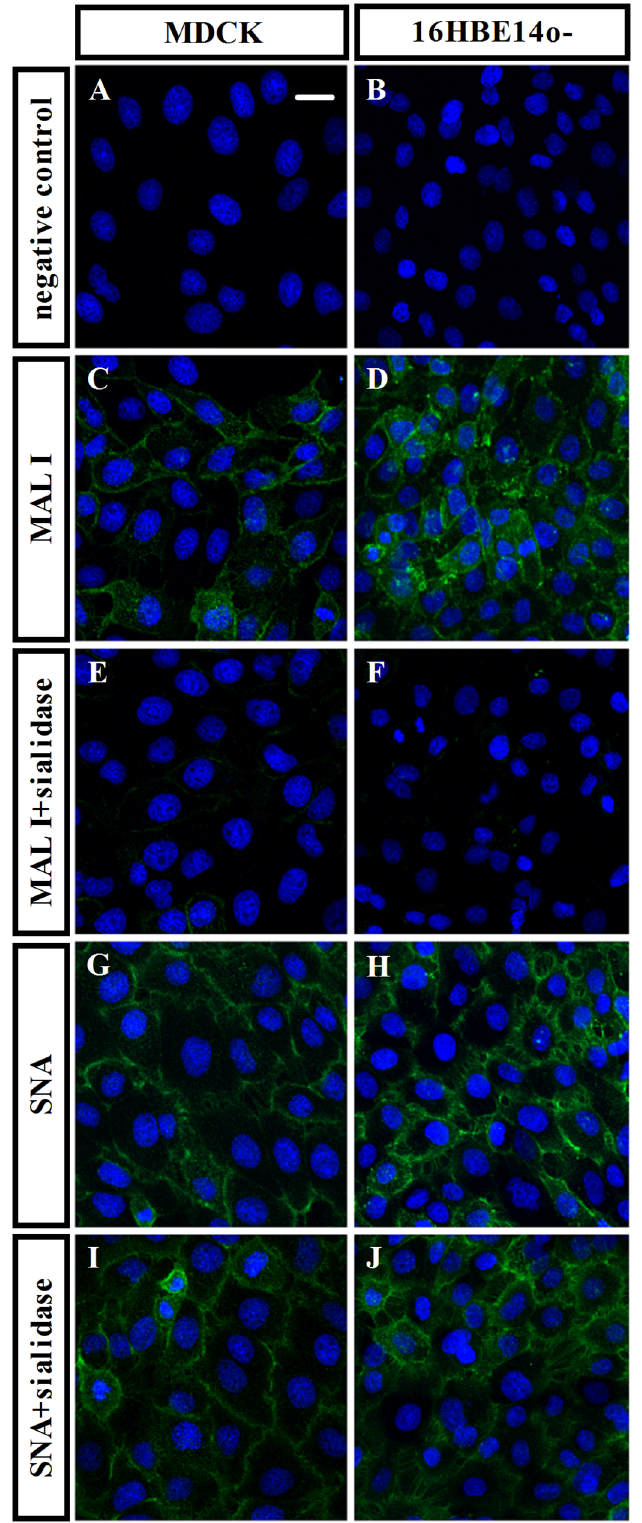
Fig 2. α -2,3 sialic acid receptoris expressedin 16HBE14o-cells. Representative confocalimages (800 × ) of 16HBE14o- cells (B , D , F , H and J) or MDCK cells (A , C , E , G and I) treated with DAPI (blue), to stain